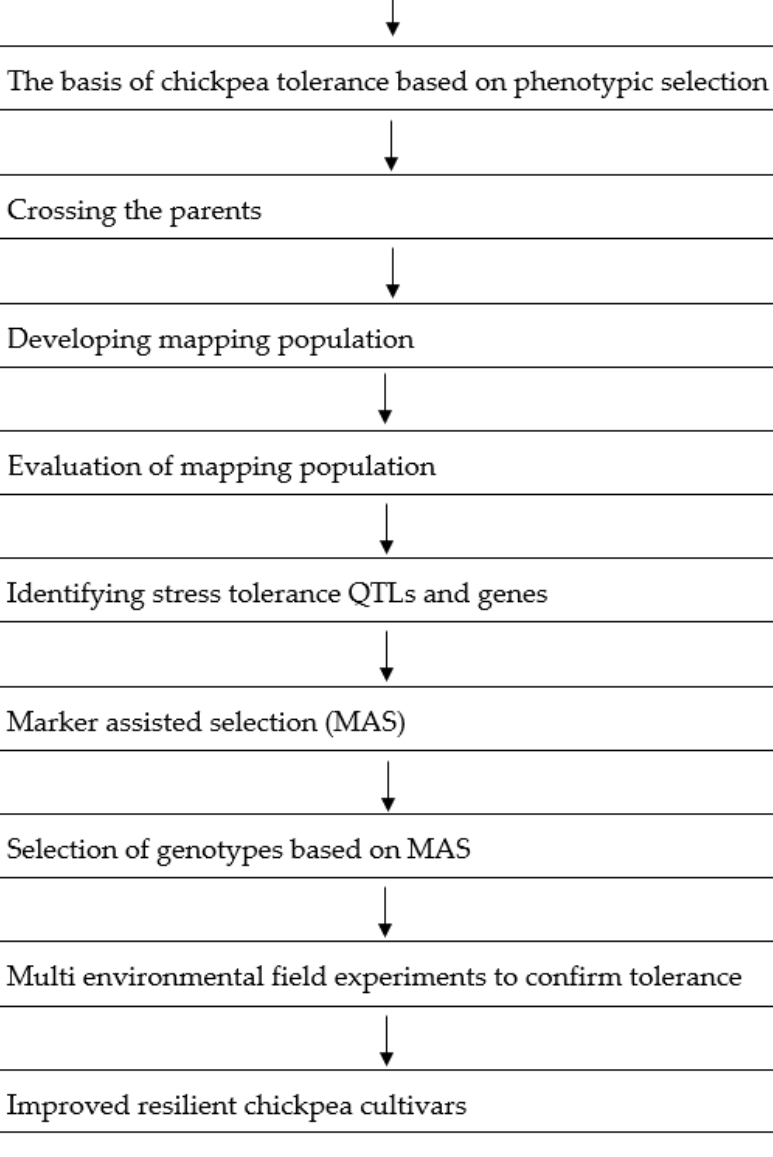
Figure 1. The strategic approaches to developing resilient cultivar.